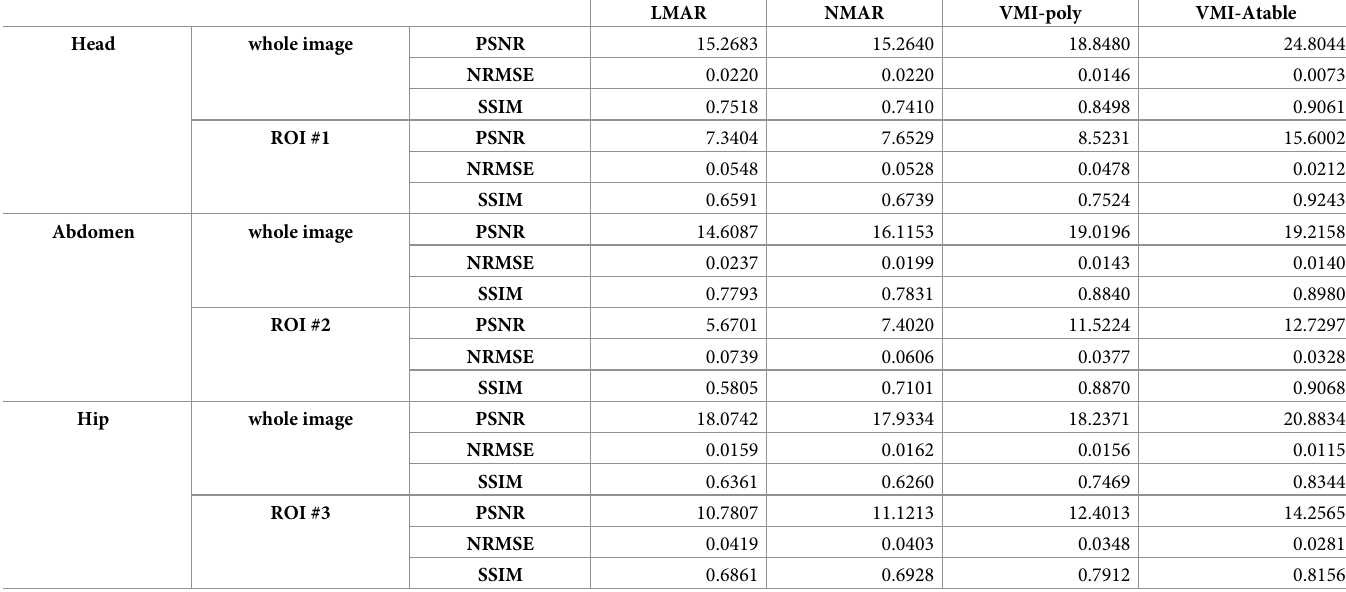
Table 3. Quantitative data of the MAR methods with XCAT